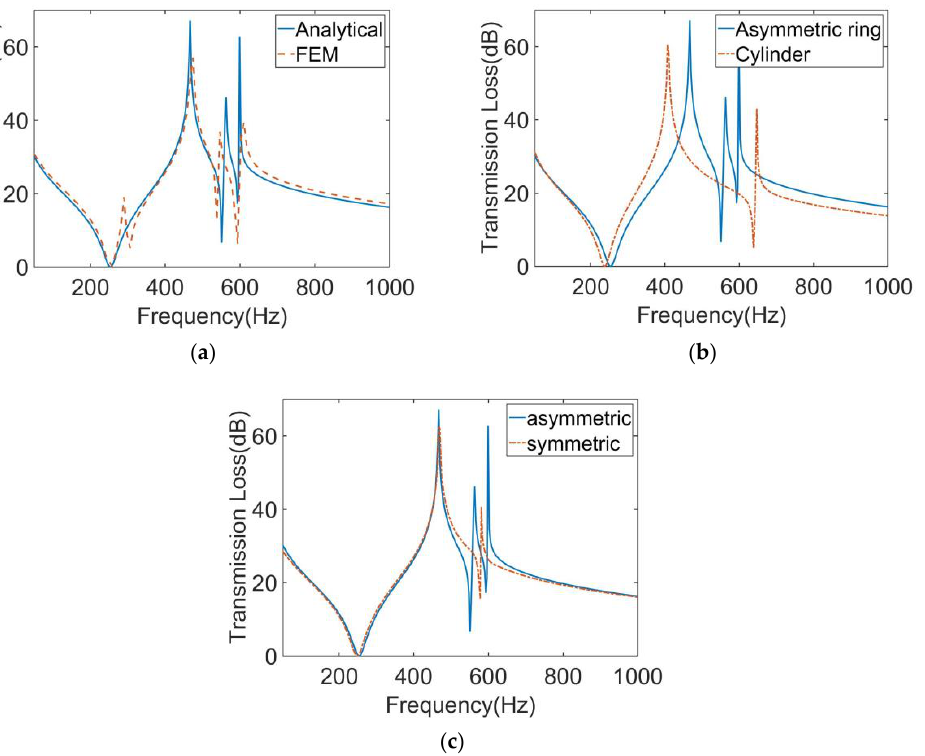
Figure 6. ( a ) Comparison of the analytical and numerical results for the STL curve of the MAM with two asymmetric rings. ( b ) Comparison of the MAMs with two asymmetric rings and two cylinders for the STL curve. ( c ) Comparison of the MAMs with two asymmetric rings, asymmetrically and symmetrically arranged.